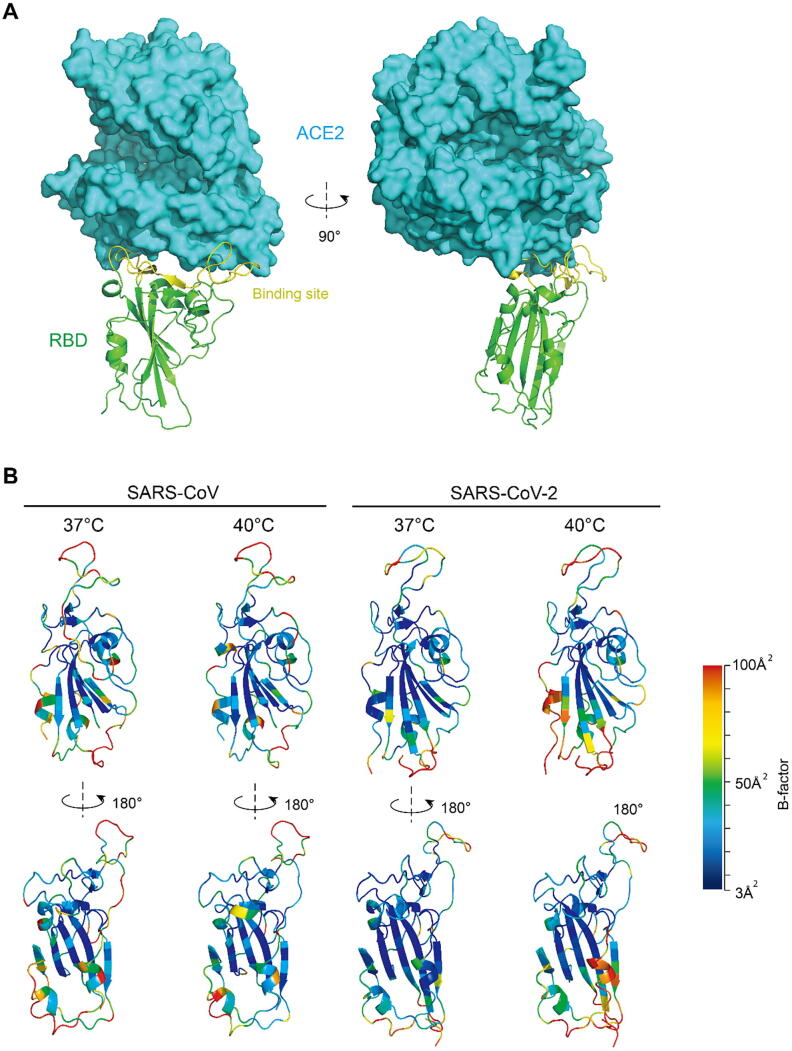
Structural basis of the temperature-dependence of the binding affinity. (A) Structure of SARS-CoV-2 RBD and human ACE2 complex. (B) The RBD backbone colored according to the B-factors of each amino acid. Higher B-factor means larger fluctuation, i.e. more flexible.